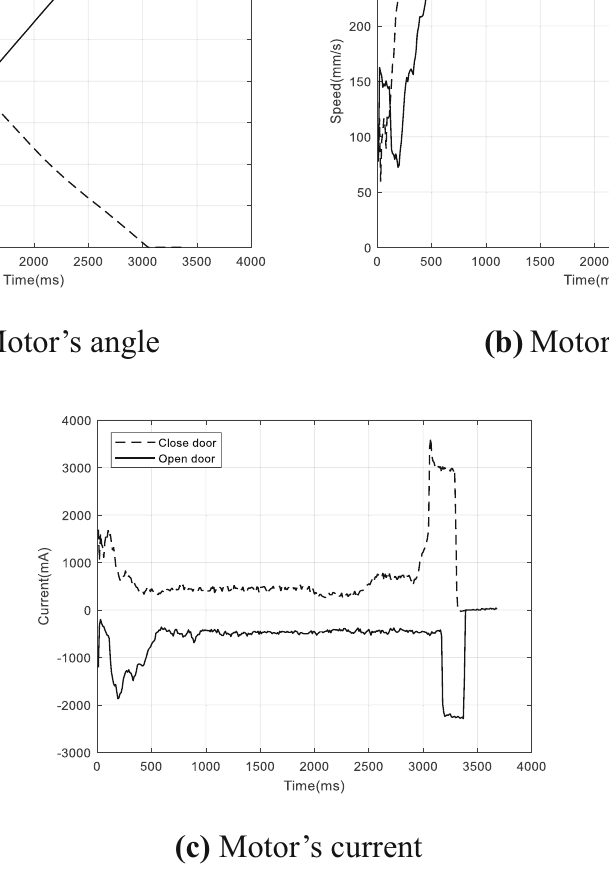
Fig. 4 Characteristic curves of rail vehicle door during opening and closing process